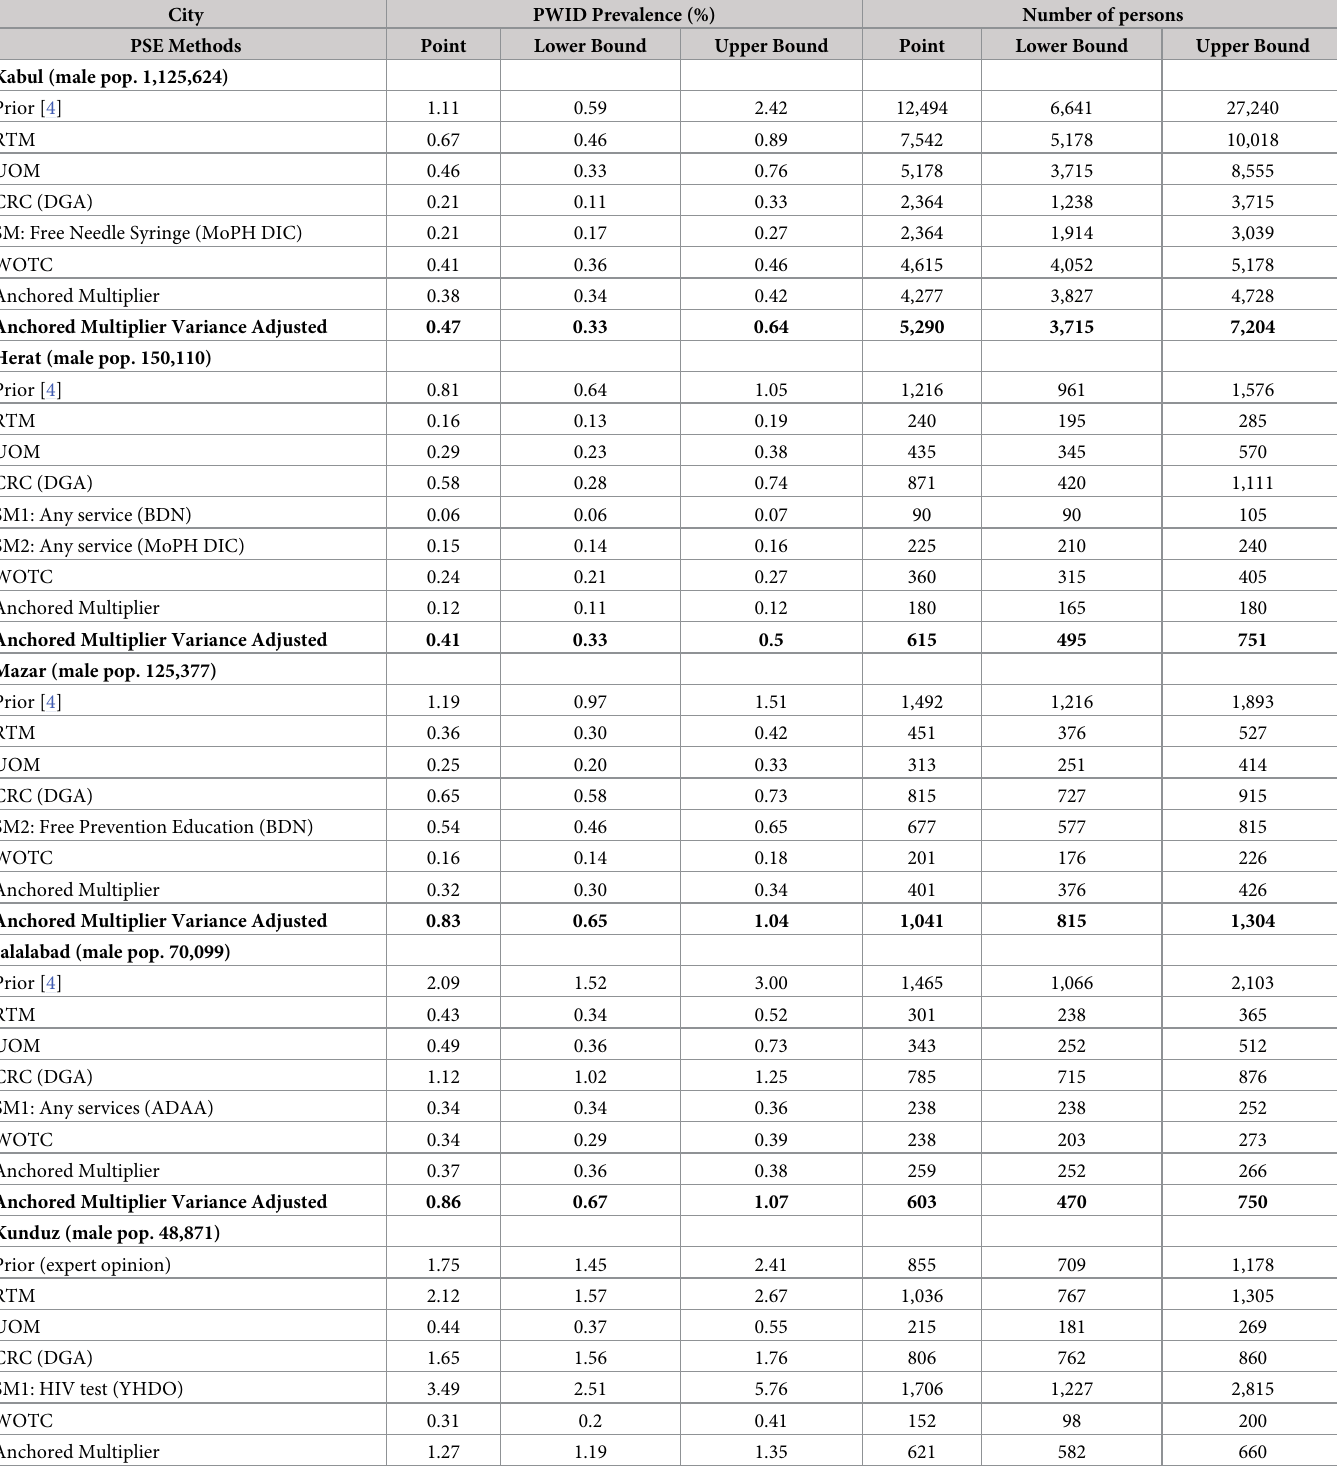
Table 7. Population size estimates (PSE) of male people who inject drugs (PWID) as a synthesis of multiple methods using the anchored multiplier bayesian approach, eight cities in Afghanistan, 2019 (unadjusted for winter seasonality). City PWID Prevalence (%) Number of persons PSE Methods Point Lower Bound Upper Bound Point Lower Bound Upper Bound Kabul (male pop. 1,125,624)